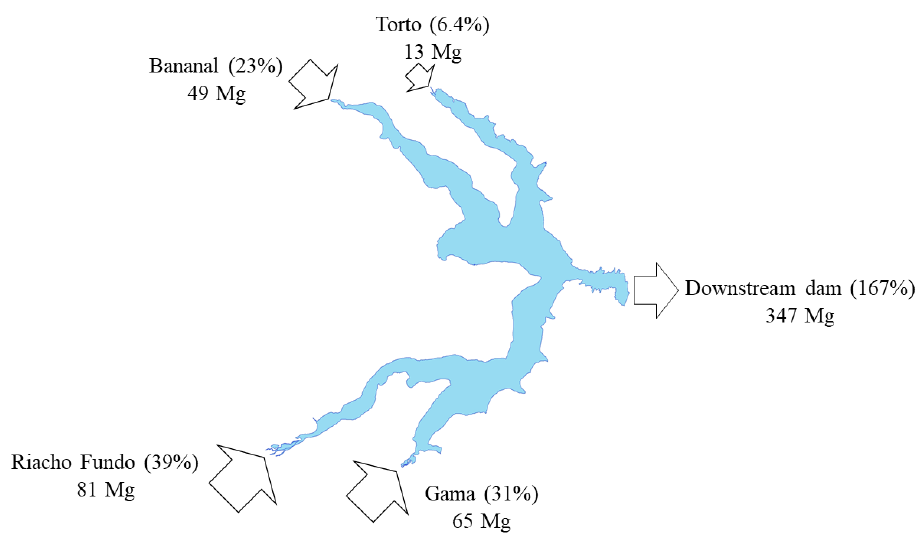
Figure 5. Annual total organic nitrogen (TON) budget for Lake Paranoá.